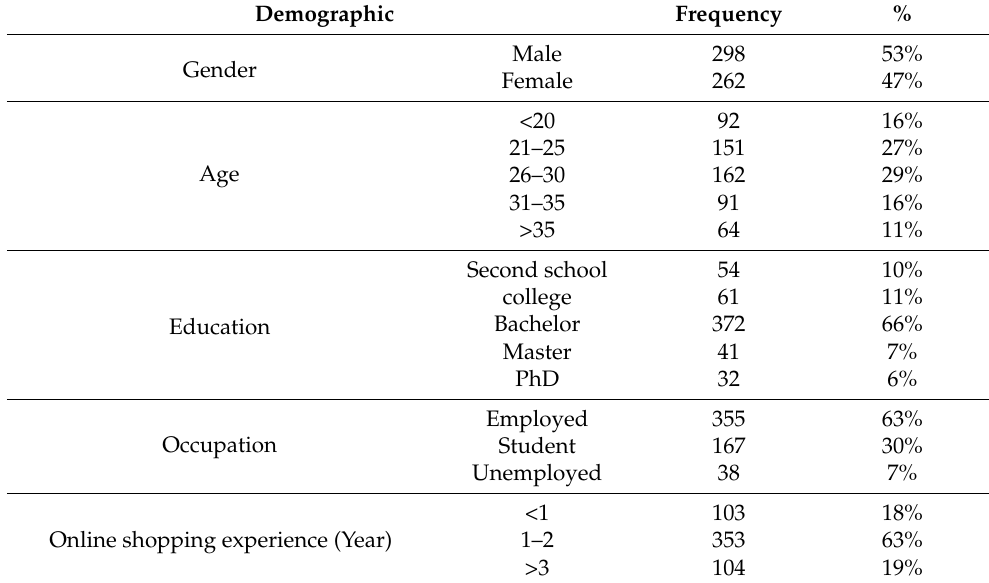
Table 1. Demographic profile of the respondents ( n =